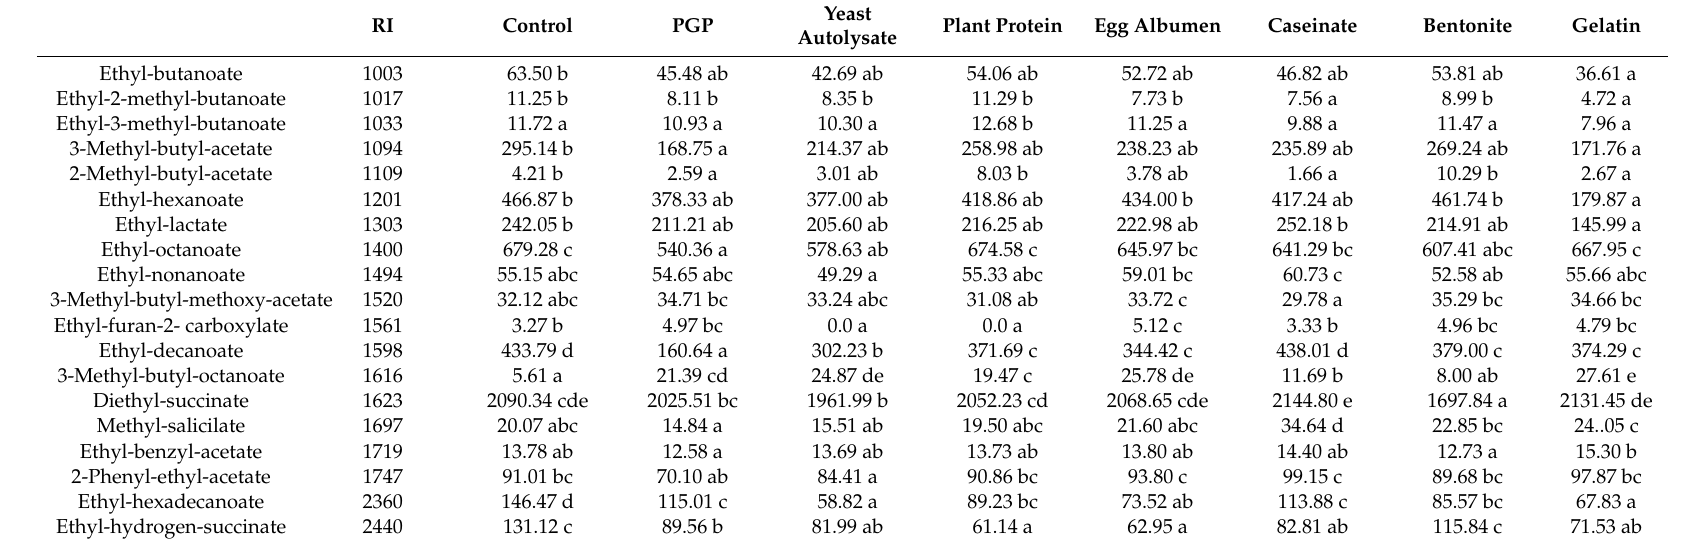
Table 2. E ff ect of the fining agents on ester compounds ( µ g equivalents of 2-octanol / L).